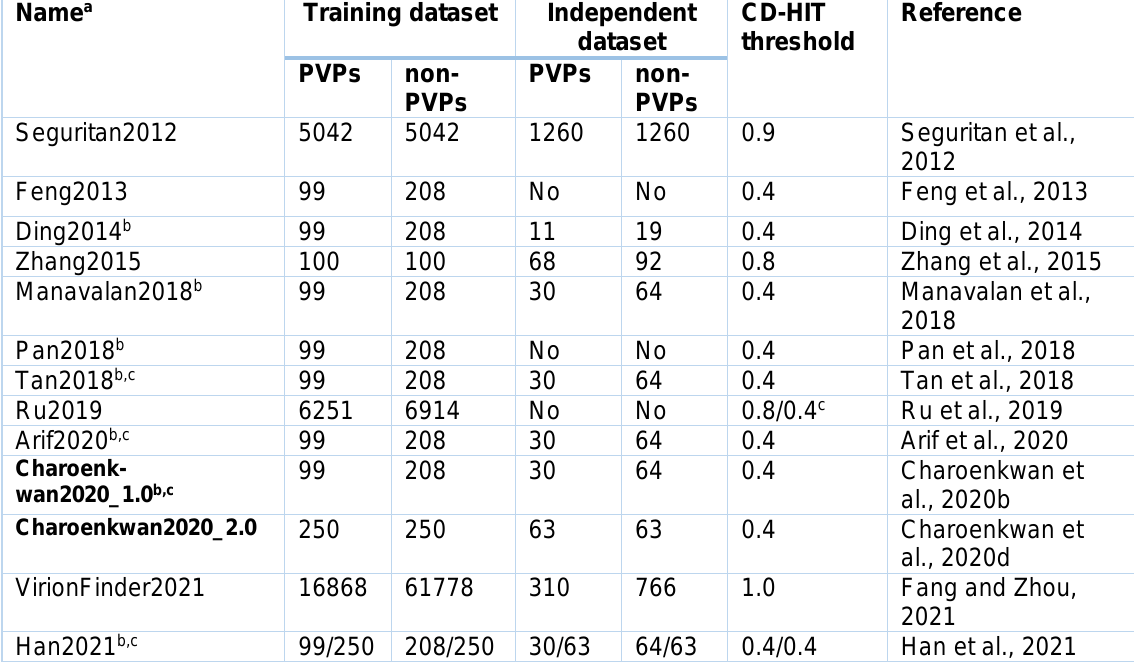
Table 2: A summary of training and independent test datasets used in PVP predictors Name